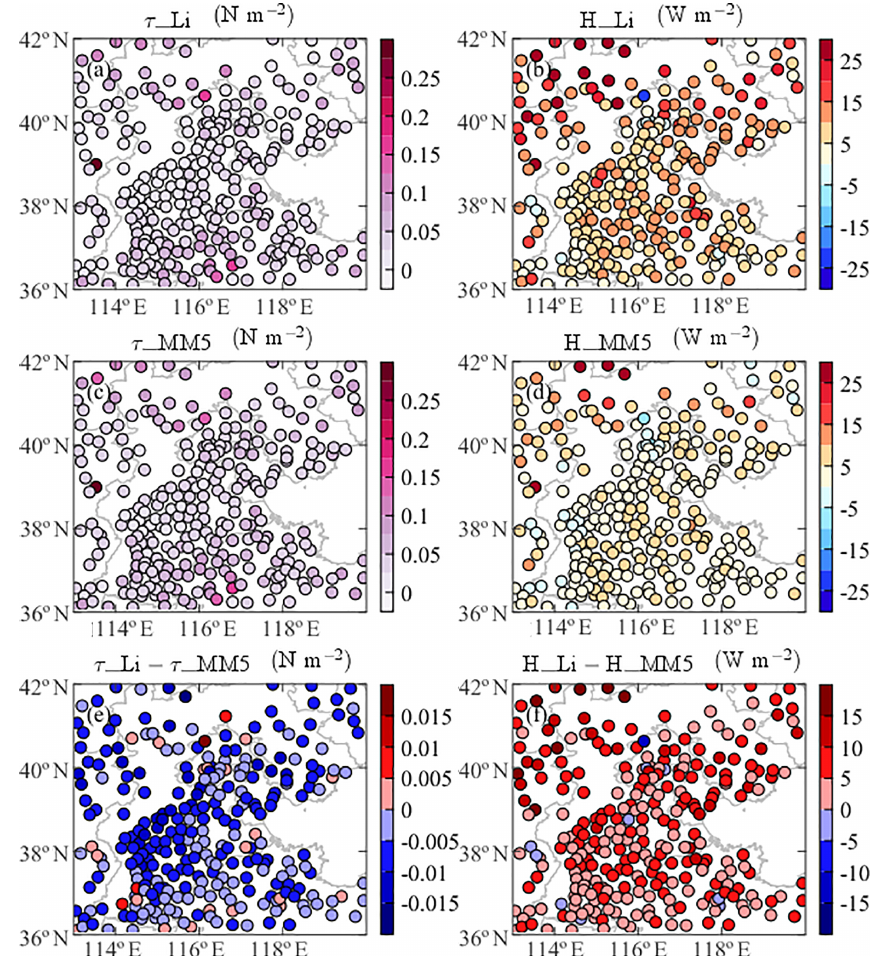
Figure 10. The mean momentum and sensible heat fluxes calculated using two schemes ( a, b : the Li scheme; c, d : the MM5 scheme) and their differences (Li minus MM5. e : momentum fluxes; f : sensible heat fluxes) in Jing-Jin-Ji during the haze episode (13 to 23 December